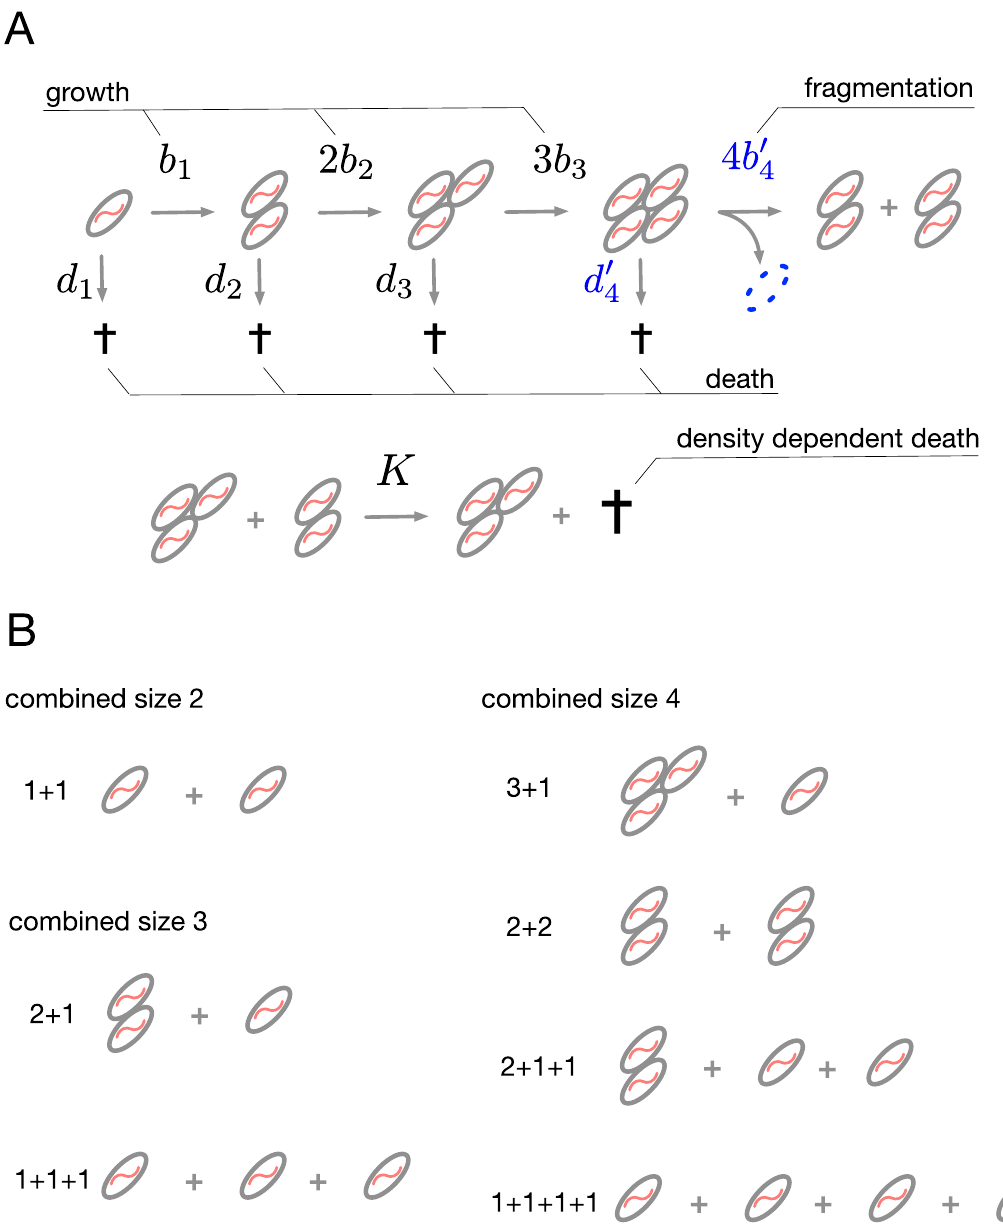
� b (see Eq (1)), the death rate at the m m � d (see Eq (2)), and some cells may be lost upon the m m